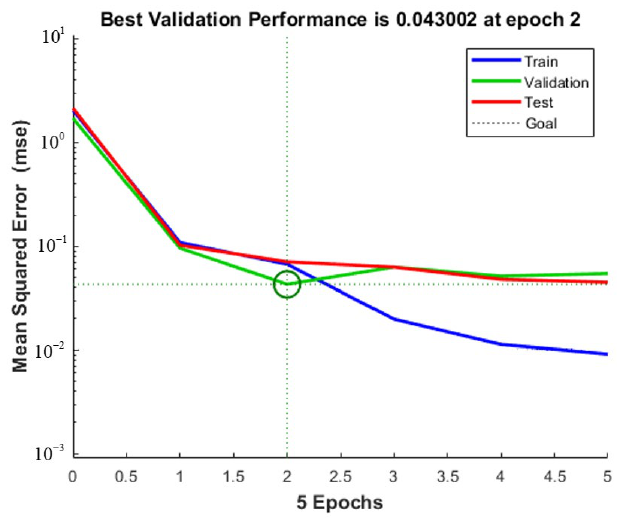
Figure 13. Milling force training process curve.